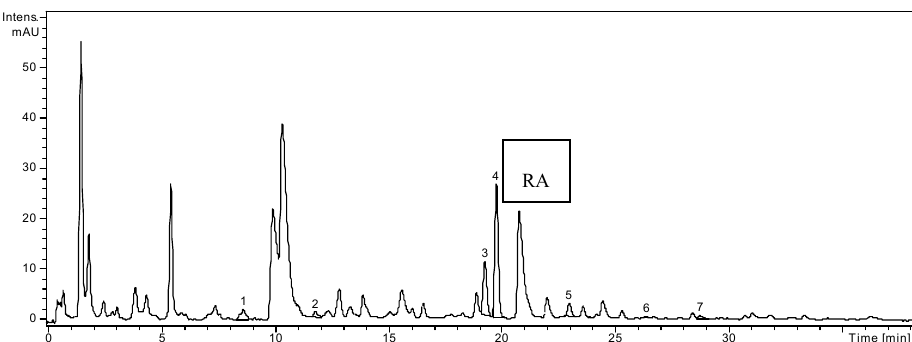
Figure 2. HPLC chromatogram of O.basilicum sample